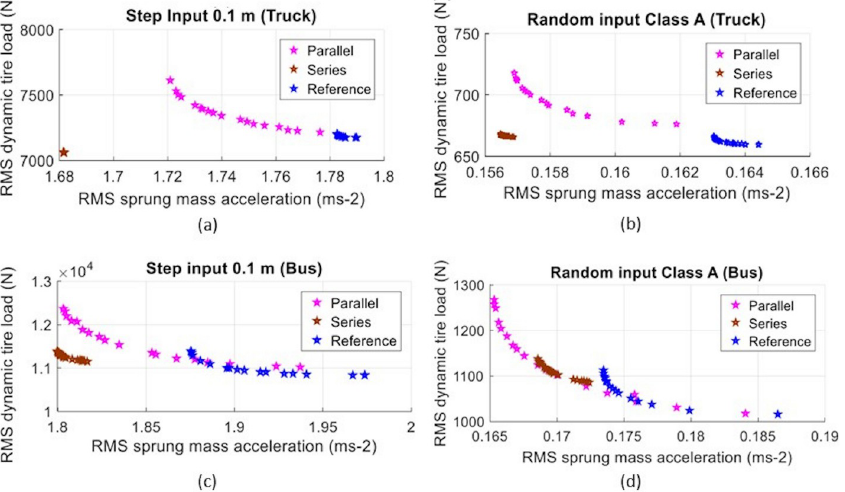
Fig 4. Pareto fronts for truck considering (a) step road input and (b) random road input, with the same optimization for bus considering (c) step road input and (d) random road input.